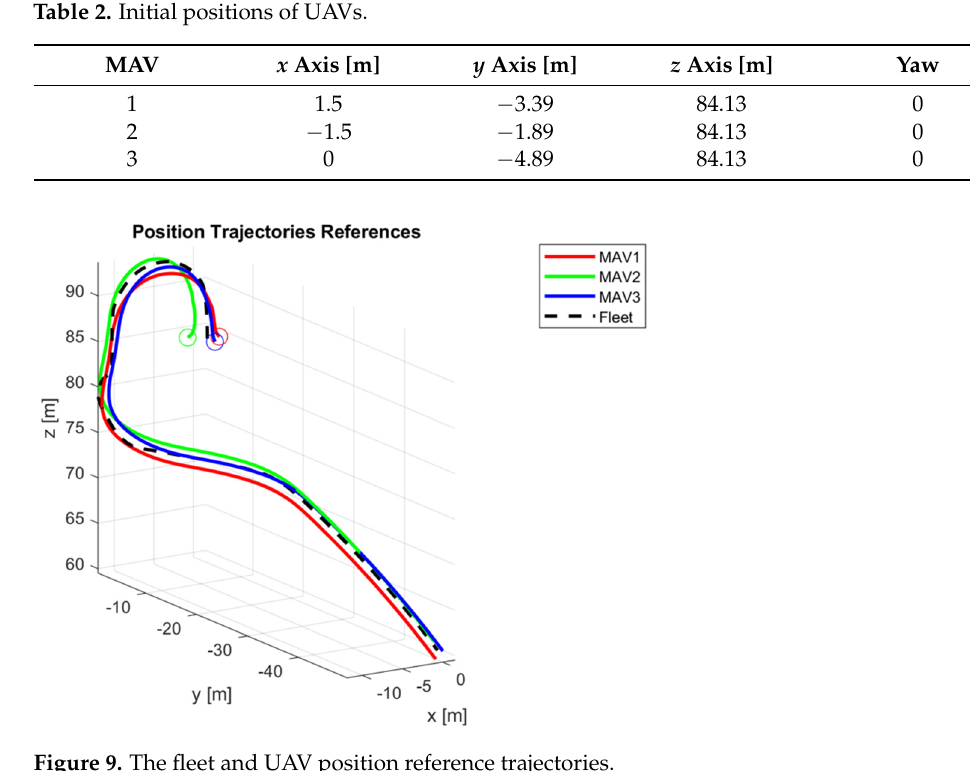
Figure 9. The fleet and UAV position reference trajectories .